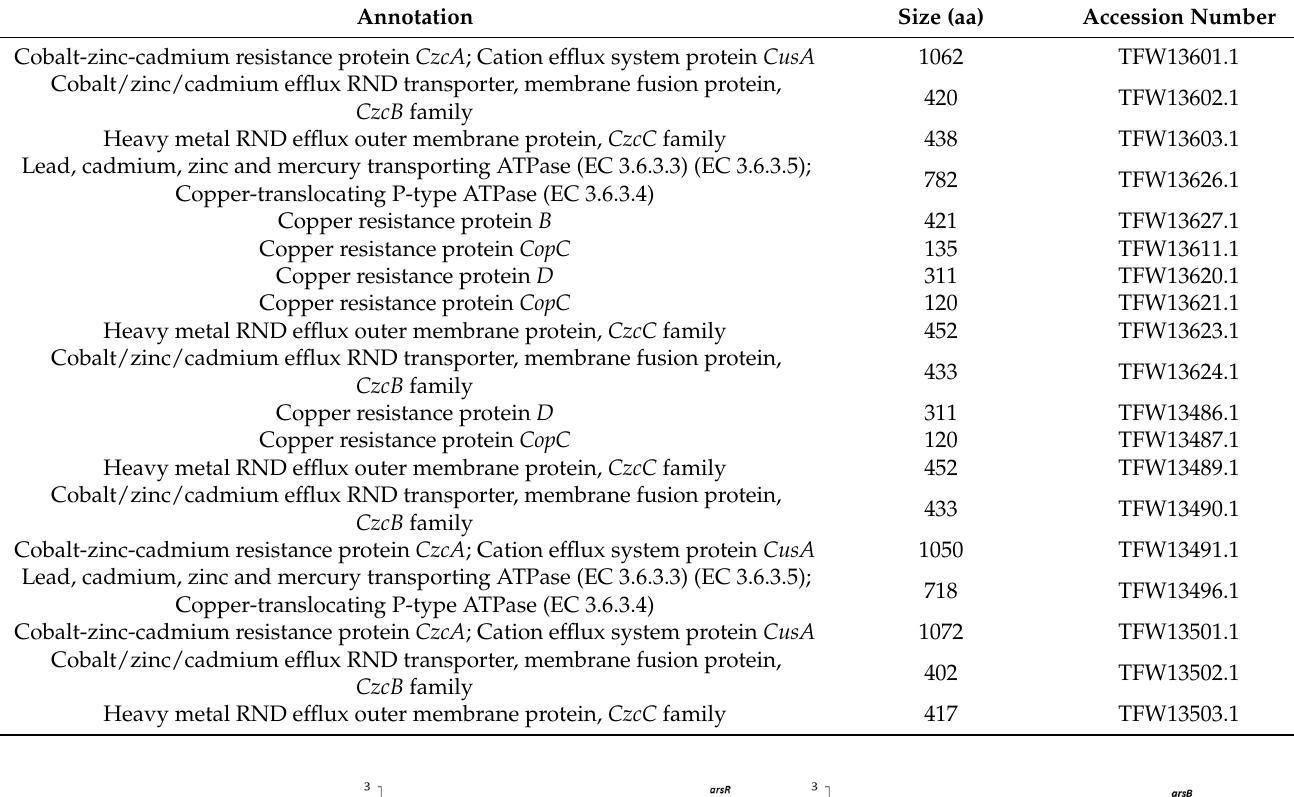
Table 4. List of heavy metal resistance-related genes found in Brevundimonas sp. B10.